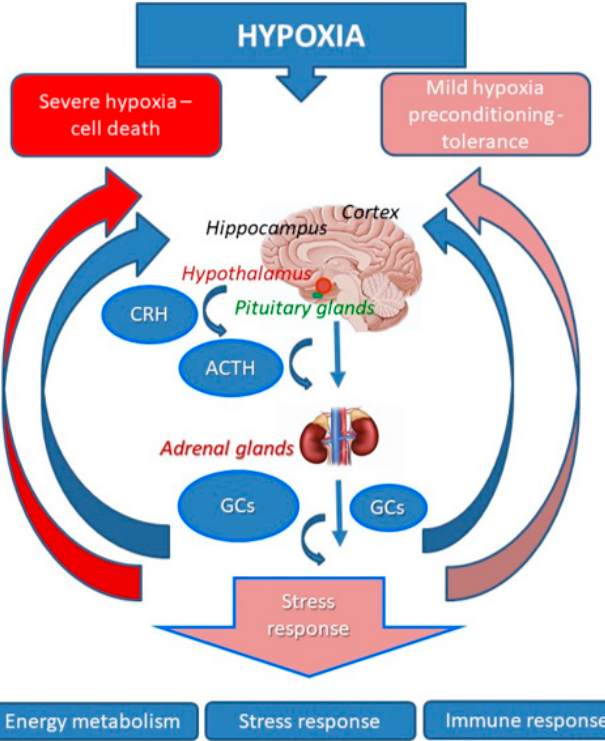
Figure 1. Schematic representation of HPA and glucocorticoid response to hypoxia and hypoxic pre-conditioning. Hypoxia induces the hypothalamus to produce and release corticotropin-releasing hormone (CRH), under whose action the anterior pituitary gland releases a number of stress-related hormones, including the adrenocorticotropic hormone (ACTH). ACTH stimulates cells of the adrenal glands to produce and release the GC stress hormone cortisol (corticosterone). GCs, via a feed-back mechanism, control the release of CRH and ACTH, and also affect metabolism of other neuronal cells. Severe hypoxia results in elevated levels of GCs resulting in neuroinflammation and neuronal cell death. On the other hand, pre-conditioning to mild hypoxia attenuates GC levels, resulting in development of neuronal cell adaptive mechanisms and brain tolerance to further severe hypoxia episodes or effects of other stressors.